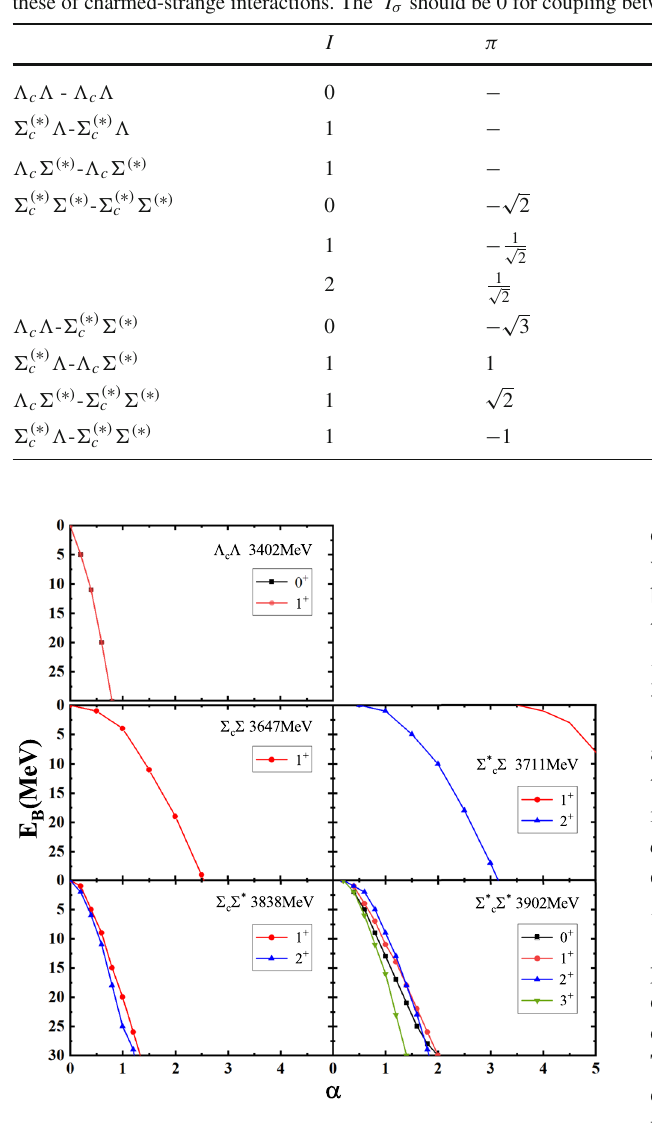
Fig. 1 Binding energies of isoscalar bound states from the charmed- strange interactionswiththevariationof α insingle-channel